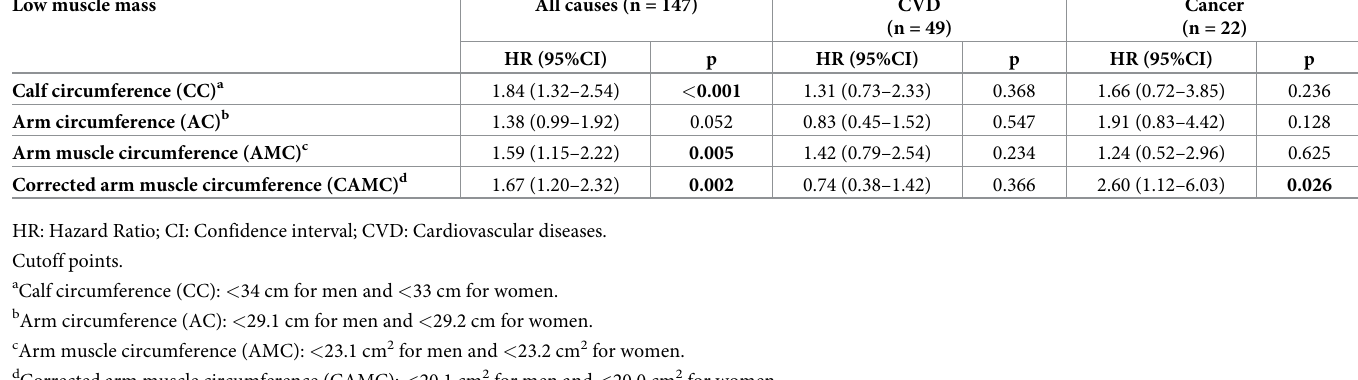
Table 3. Cox’s crude proportional risk analysis to assess associations of low muscle according to anthropometric measures with all-cause mortality, CVD and cancer. Low muscle mass